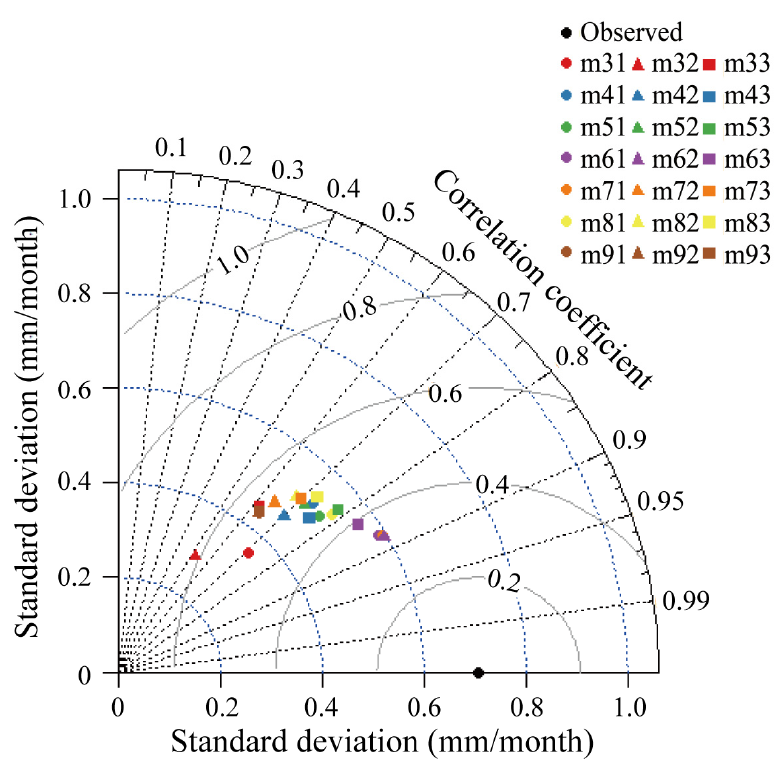
Figure 4. Taylor diagram of all the models.